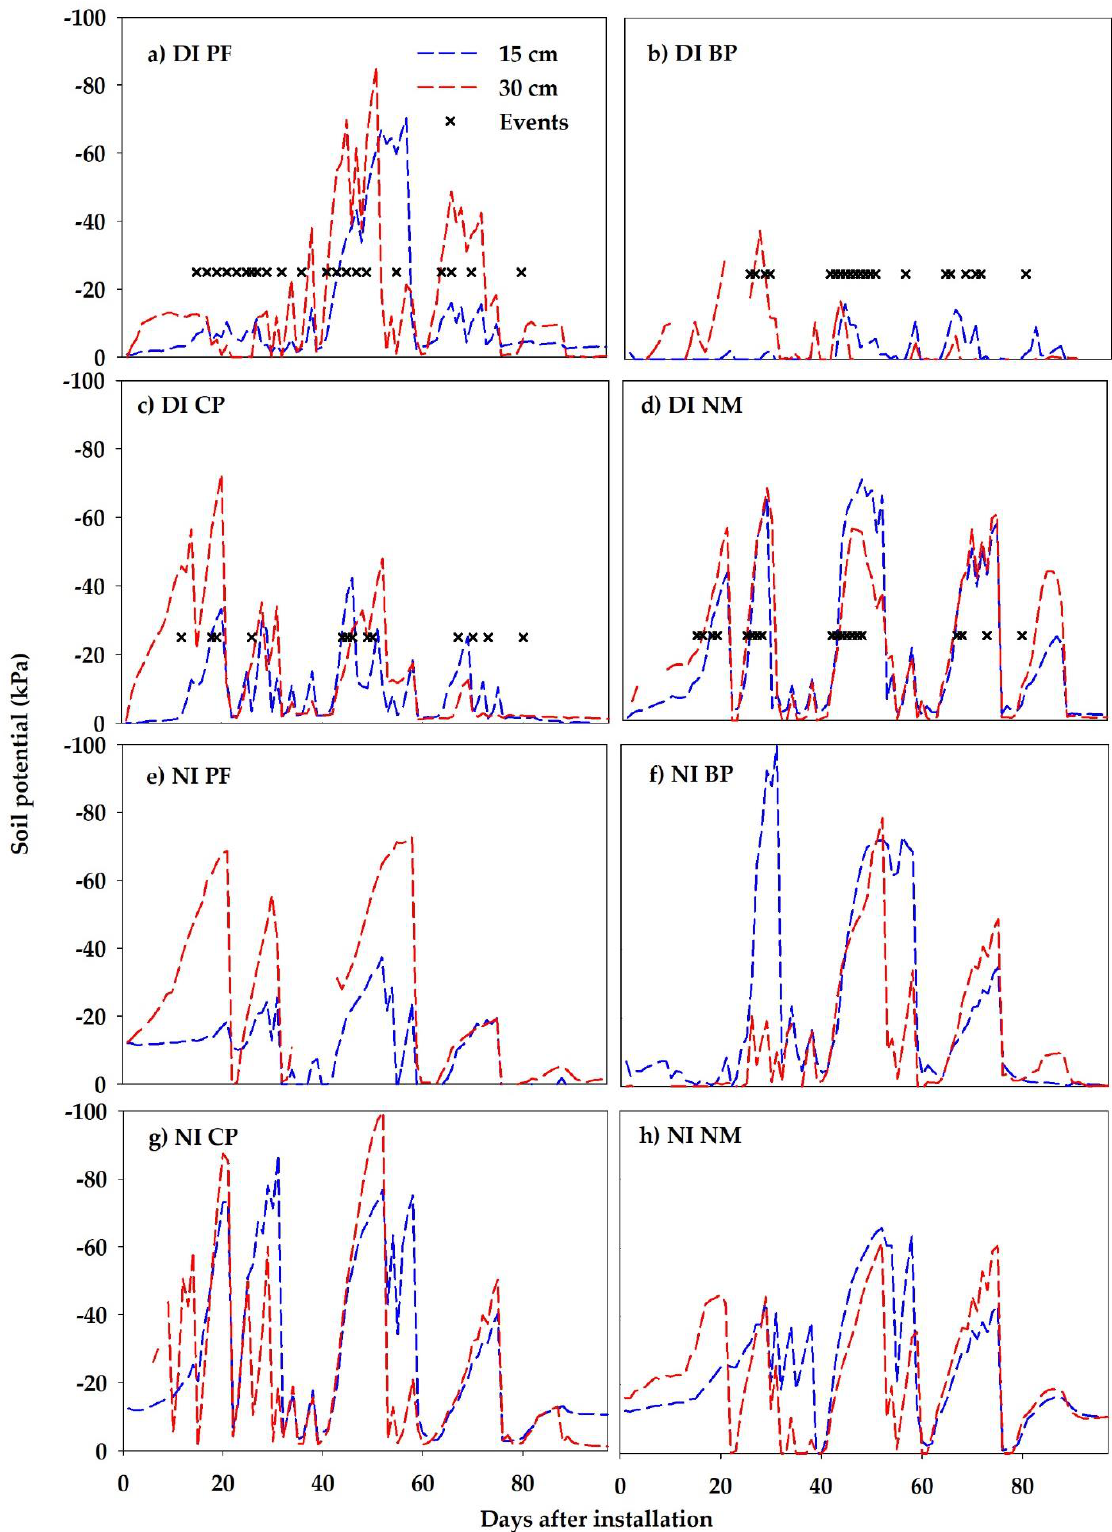
Figure 6. Daily average soil matric potential (08:00 am) at 15 and 30 cm deep in watermelon plots during 2019 field experiment under drip irrigation (DI) treatment with ( a ) landscape fabric mulch (DI PF), ( b ) black plastic mulch (DI BP), ( c ) clear plastic mulch (DI CP), ( d ) no mulch (DI NM), and no irrigation treatment (NI) with ( e ) landscape fabric mulch (NI PF), ( f ) black plastic mulch (NI BP), ( g ) clear plastic mulch (NI CP), and ( h ) no mulch (NI NM).